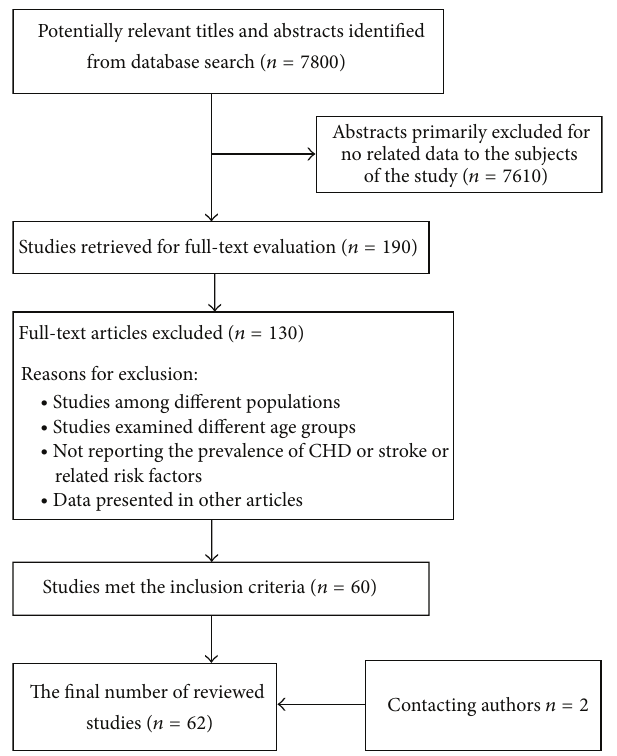
Figure 1: Study selection